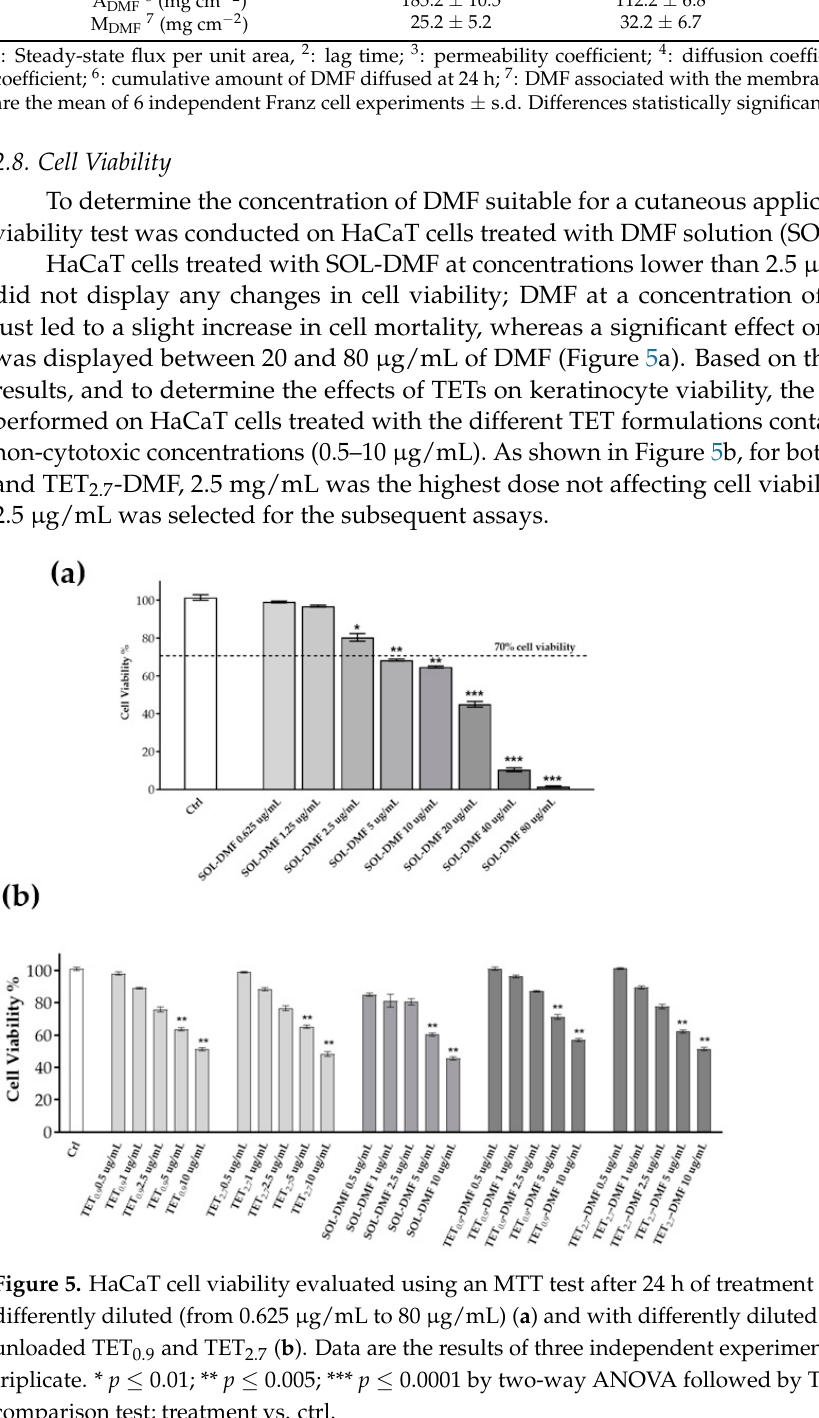
comparison test; treatment vs.